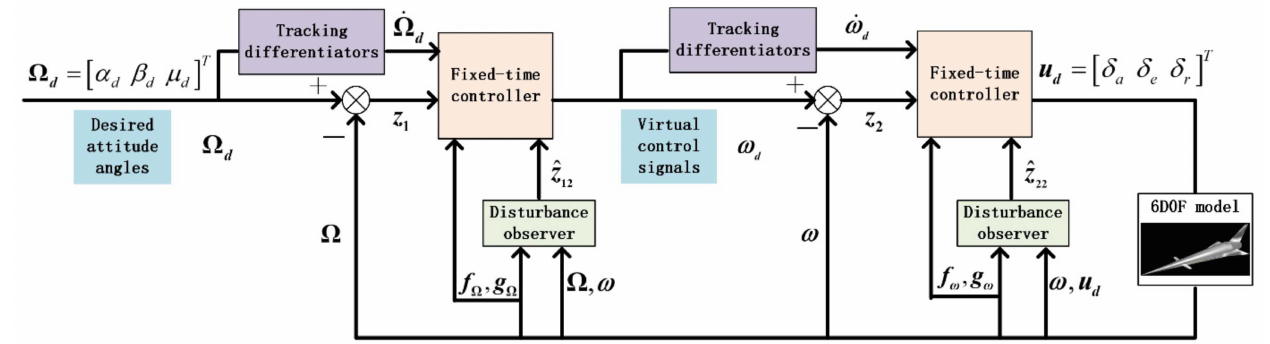
Figure 1. Structure of the proposed